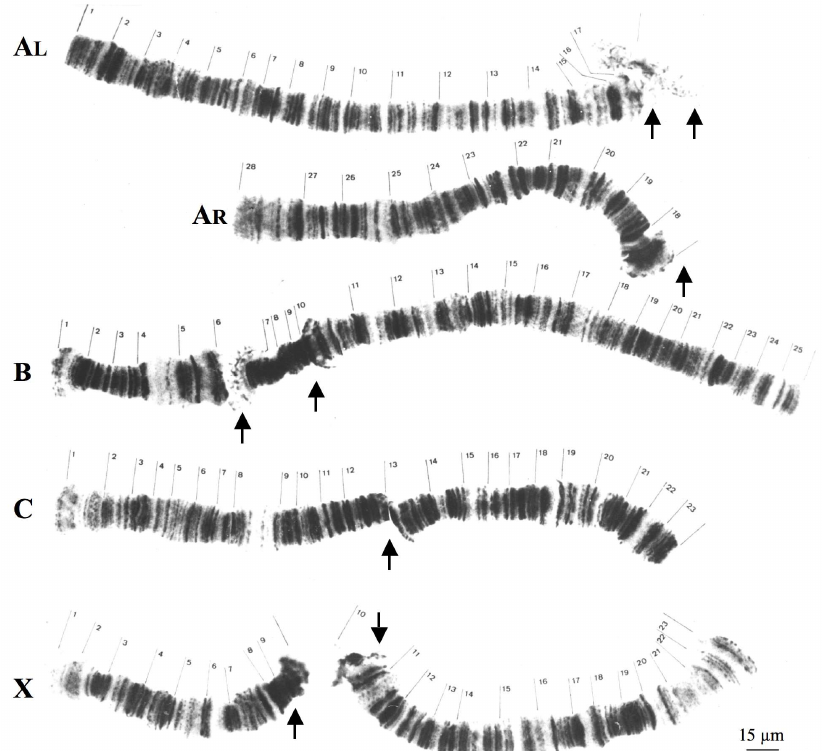
Figure 2. Polytene chromosomes of T. pubescens modified from [32]. AL and AR correspond respectively to long and short arms of chromosome A. The arrows indicate the most frequent breakpoint regions in each chromosome. Chromosomenomenclature( A – D